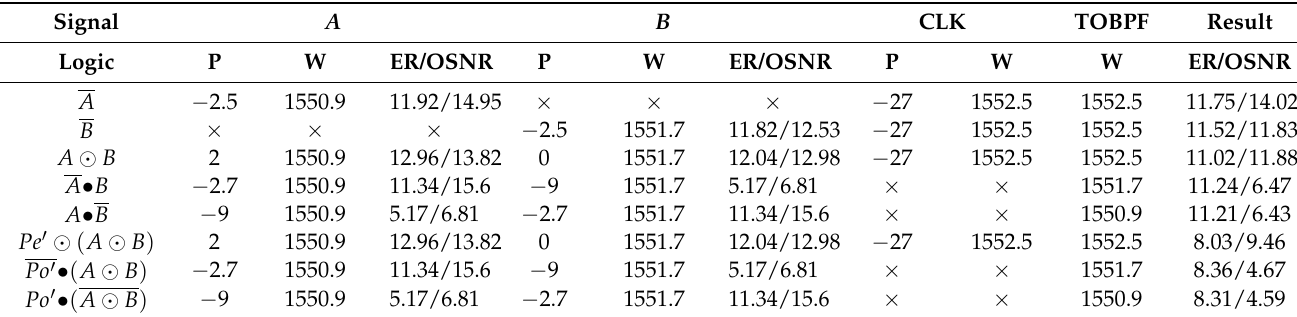
Table 4. Experimental parameters with logic gates (P: power with dBm unit; W: wavelength with nm unit; ER: extinction ratio with dB unit; OSNR: optical signal to noise ratio with dB unit). Signal A B CLK TOBPF Result